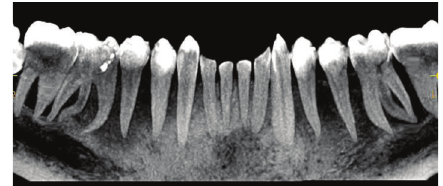
Figure 6: Curved slicing section showing 36 and 46.